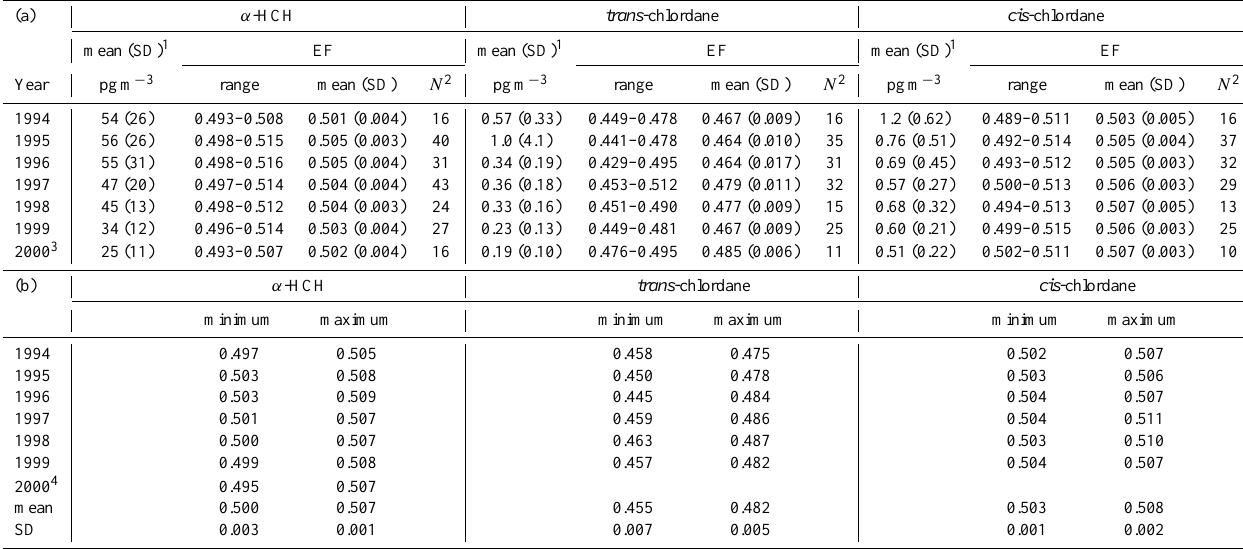
Table 1. (a) Annual mean concentrations and EFs of organochlorine pesticides at Alert, Canada. (b) Annual minima and maxima EFs, from fitted DF